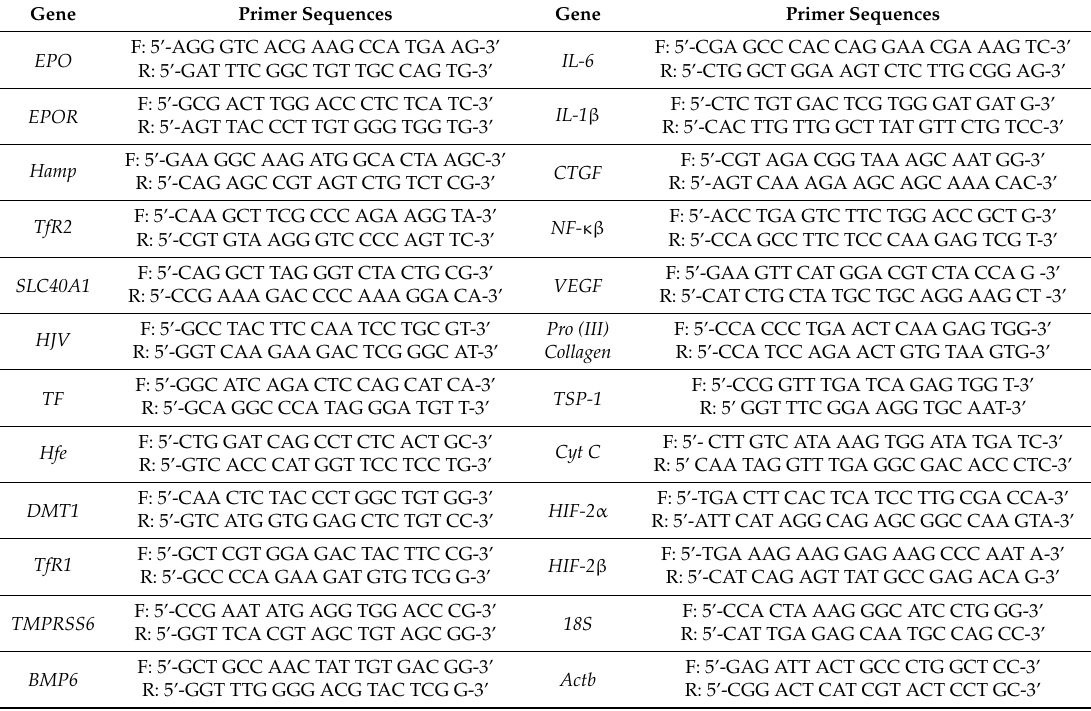
Table 4. List of primer sequences (F: forward; R: